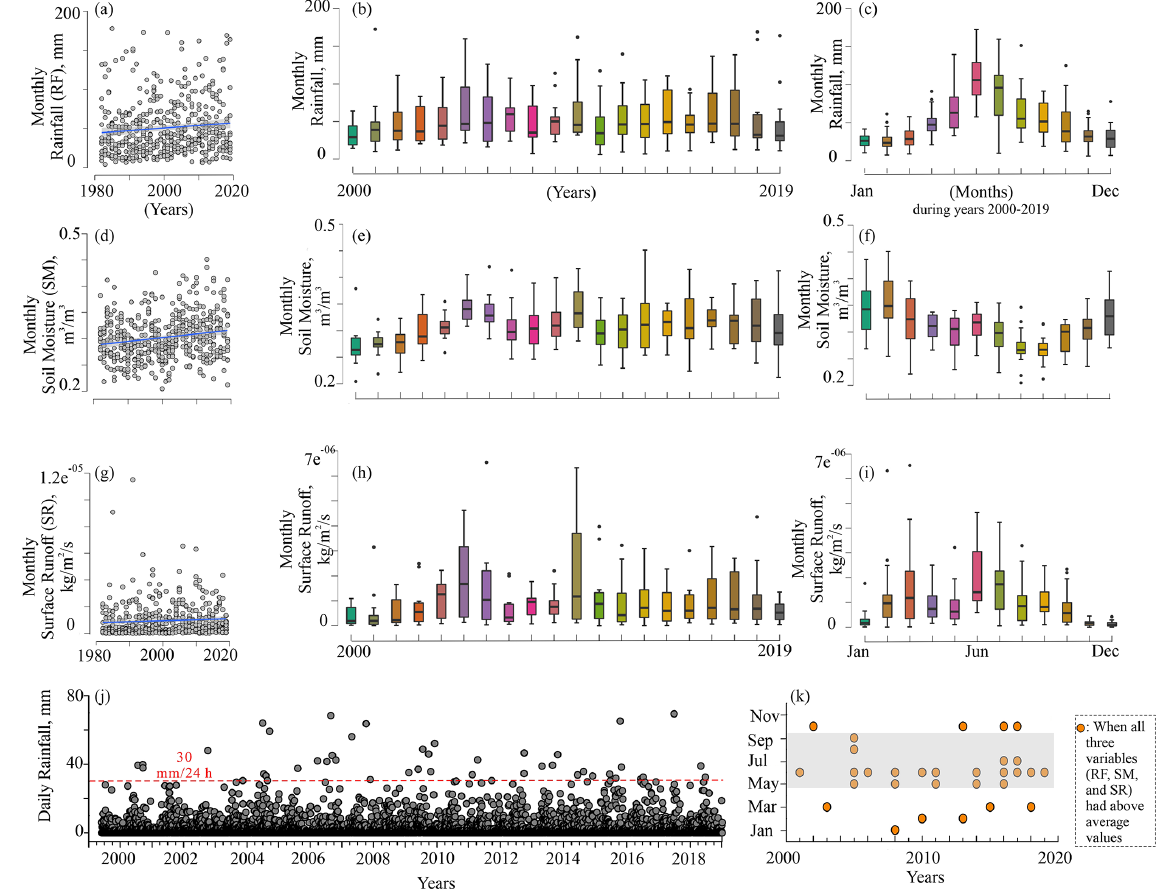
Figure 3. Rainfall (RF), soil moisture (SM), and surface runoff (RF) pattern. The region from which these parameters are extracted is highlighted in Fig. 1. Dataset (except j ) source: FLDAS_NOAH01_C_GL_M model (McNally, 2018). Spatial resolution of dataset: 0.1 ◦ ( ∼ 10km). Data source of (j) : GPM IMERG Final Precipitation (Huffman et al., 2019). Spatial resolution of dataset: 0.1 ◦ . The rainfall data in (j) are available only from 1 June 2000. The SM and SR data are not available at a daily scale for the study area. The blue line (in a, d, g ) indicates linear regression, and the shaded region around it refers to the 95% confidence interval. Dots in box plots refer to outliers. The red line in (j) refers to extreme rainfall (30mmd − 1 ). The grey-shaded region in (k) refers to those months that witnessed above-average values of RF, SM, and